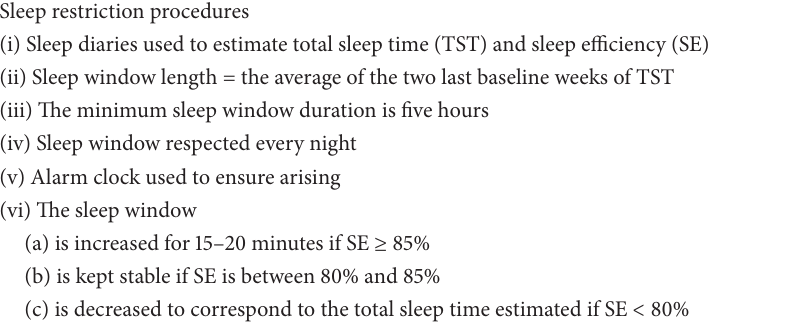
Table 1: Summary content of the sleep restriction